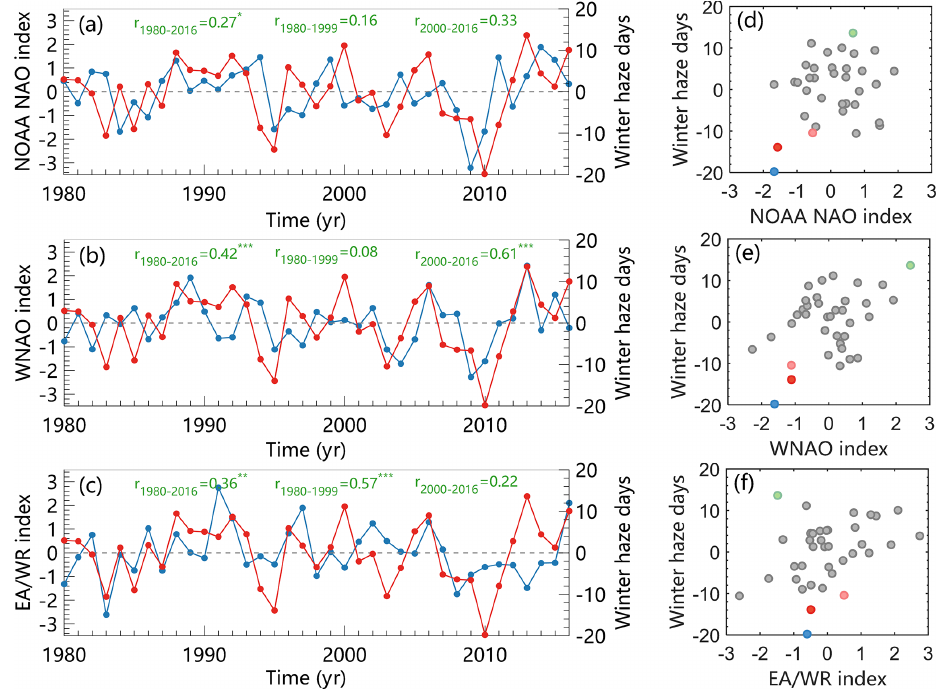
Figure 2. Time series of detrended winter haze days (red) and (a) NOAA NAO index (blue), (b) WNAO index (blue) and (c) NOAA EA/WR index (blue). Correlation coefficients between winter haze days and the three indices during the periods 1980–2016, 1980–1999 and 2000– 2016 are labeled at the top of each panel. The 90%, 95% and 99% confidence levels for the Student’s t test are denoted by one, two and three asterisks, respectively. Scatter diagrams of winter haze days against the (d) NOAA NAO index, (e) WNAO index and (f) EA/WR index are shown, in which the red, pink, blue and green dots represent the years 1995, 2003, 2010 and 2013, respectively.